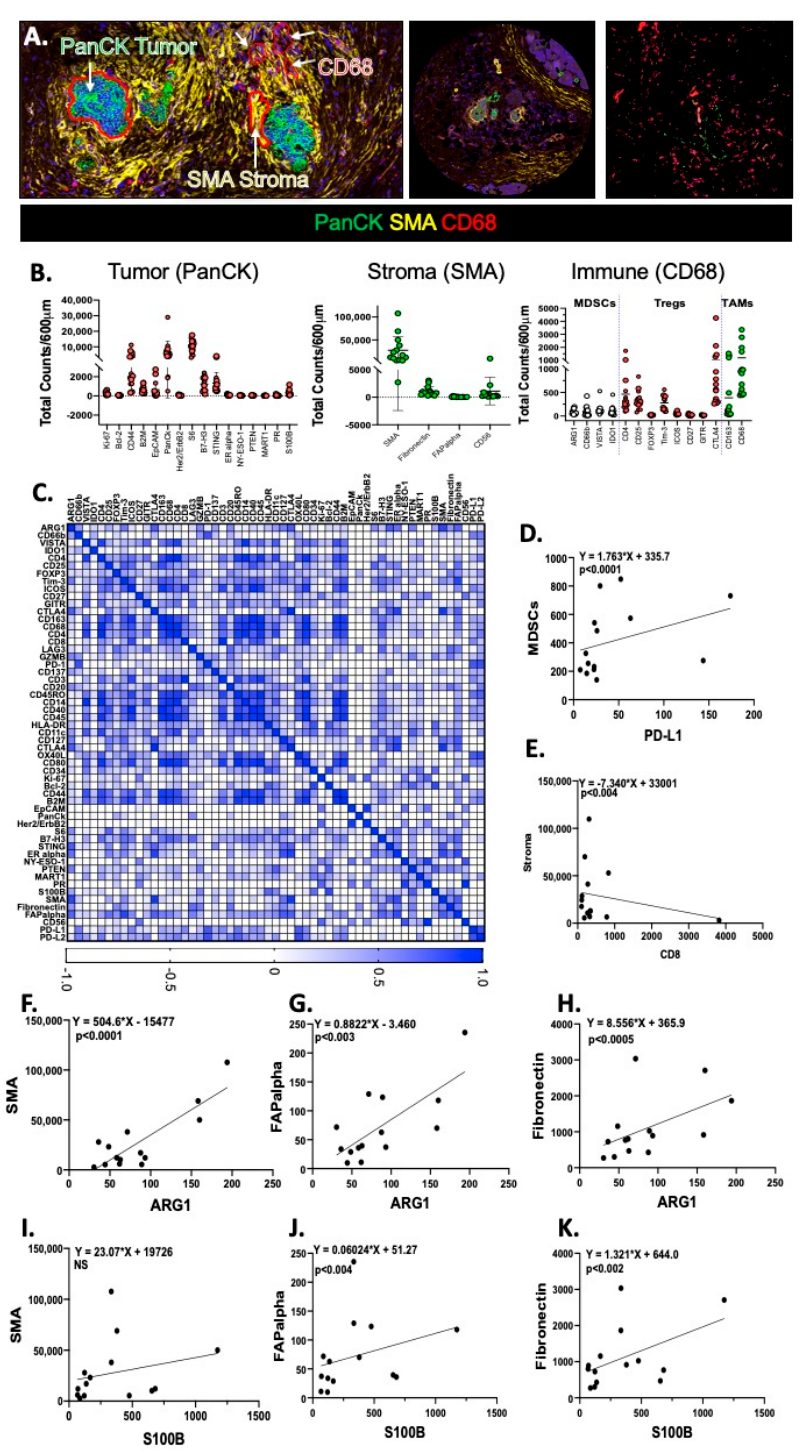
Figure 6. Correlation analysis of patient PDAC tumor tissue array using digital spatial profiling. ( A ) Digital spatial analysis demonstrating representative ROIs, and tumor (PanCK, green), stroma (SMA, yellow) and immune (CD68, red) expression in a patient pancreatic ductal adenocarcinoma tumor tissue array. Scatter plots showing ( B ) tumor, stromal and immune cell components. ( C ) Pearson correlation matrix and correlation between ( D ) MDSCs / PD-L1, ( E ) Stroma / CD8, ( F ) Arg1 / SMA, ( G ) Arg1 / FAPalpha, ( H ) Arg1 / fibronectin, ( I ) S100B / SMA, ( J ) S100B / FAPalpha, and ( K ) S100B / fibronectin. was performed. The intensity of the color at the bottom bar indicates the degree of correlation.